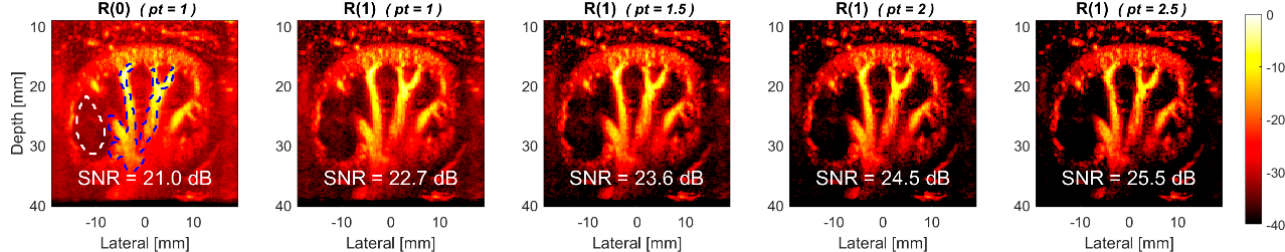
Figure 12. Experimental TMAS power Doppler images of longitudinal-view flow phantom for R(1) images with the pt values of 1.0, 1.5, 2.0 and 2.5, respectively from left to right. R(0) image is also provided as a reference. The flow velocity is 310 mm/s ( upper ) and 700 mm/s ( lower ). The inclined angle of the flow vessel is 0°.